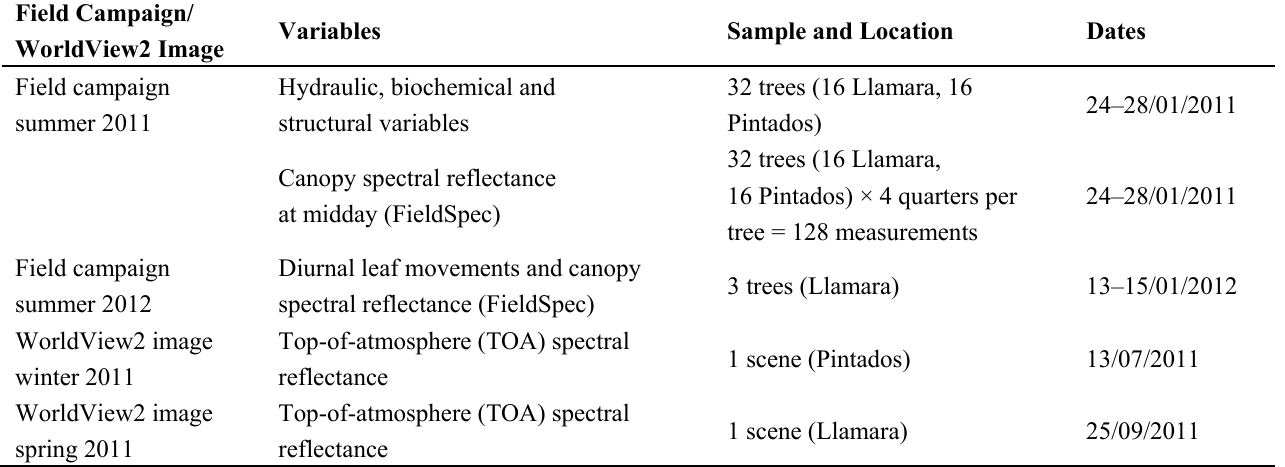
Table 1. Field campaigns and WorldView2 images used in this